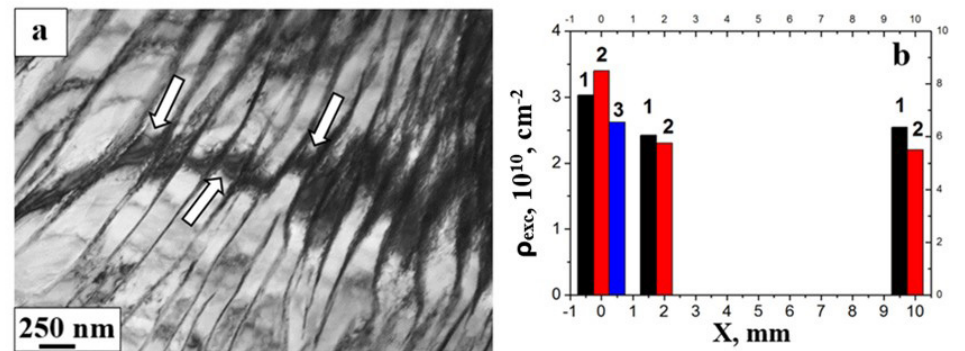
Figure 8. Electron microscopic image of rail structure in the layer located at a distance of 10 mm from fillet surface (a); b - diagram of gradient of excessive dislocation density (X - distance from working fillet surface); 1 - degenerate pearlite + fractured pearlite; 2 - lamellar pearlite; 3 - ferrite-carbide mixture. Arrows indicate in (a) the bend extinction